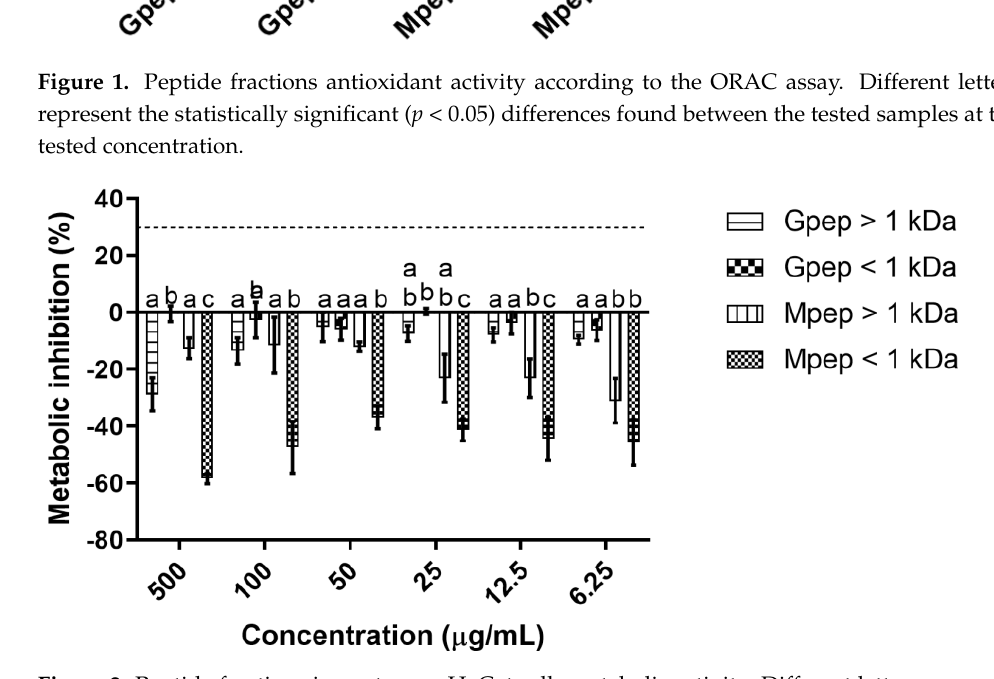
Figure 2. Peptide fractions impact upon HaCat cells metabolic activity. Different letters represent the statistically significant ( p < 0.05) differences found between the four samples tested at each concentration assayed. The dotted line represents the 30% cytotoxicity limit as defined by the ISO 10993- 5:2.